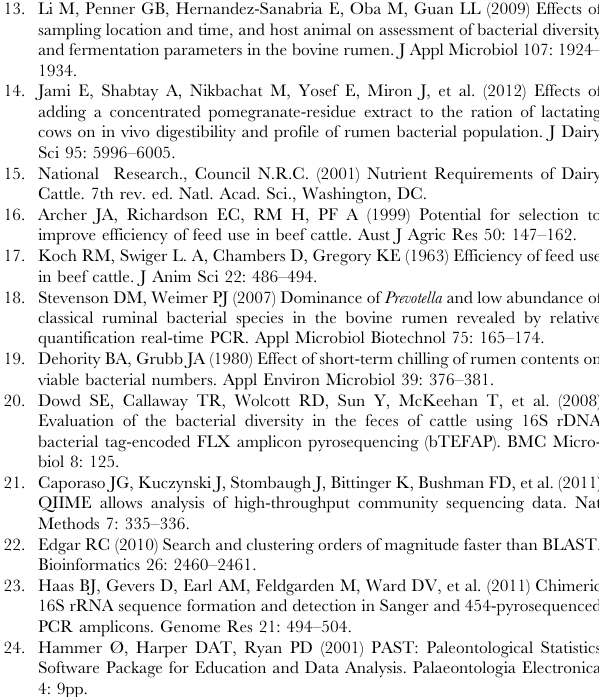
Figure S1 Genus-level rarefaction curves of rumen microbiota. Rumen microbiota from each of the 15 individual animals were sampled according to their 16S rRNA gene sequences. Figure S2 Abundance of genera of the phylum Firmi- cutes compared to the genus Prevotella . Stack plot showing the abundance levels of each of the 23 genera belonging to the phylum Firmicutes included in the correlation analyses. These include all genera that were in at least half of the cows sampled and constituted 0.1% of the reads in at least one cow. The gray portion of the bars represents the abundance of Prevotella (phylum Bacteroidetes). Figure S3 Assessment of the robustness of bacterial extraction and DNA purification protocols used in this